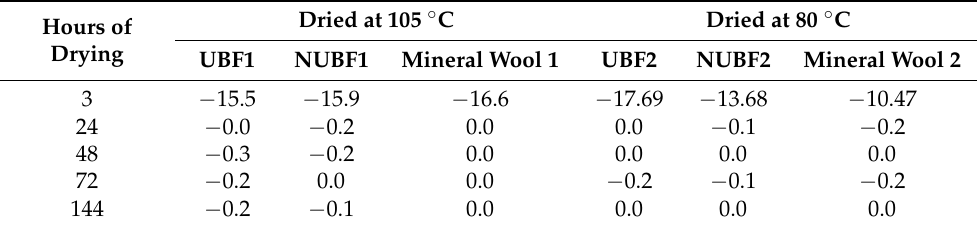
Table 2. Variation of weight of samples (%) after first drying at 105 °C and 80 °C.